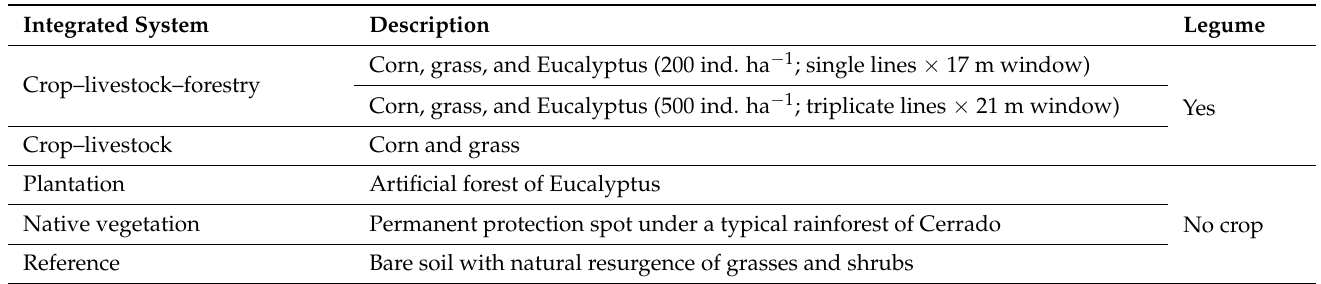
Table 1. Conditions of integrative systems for the environmental restoration of Ultisol’s